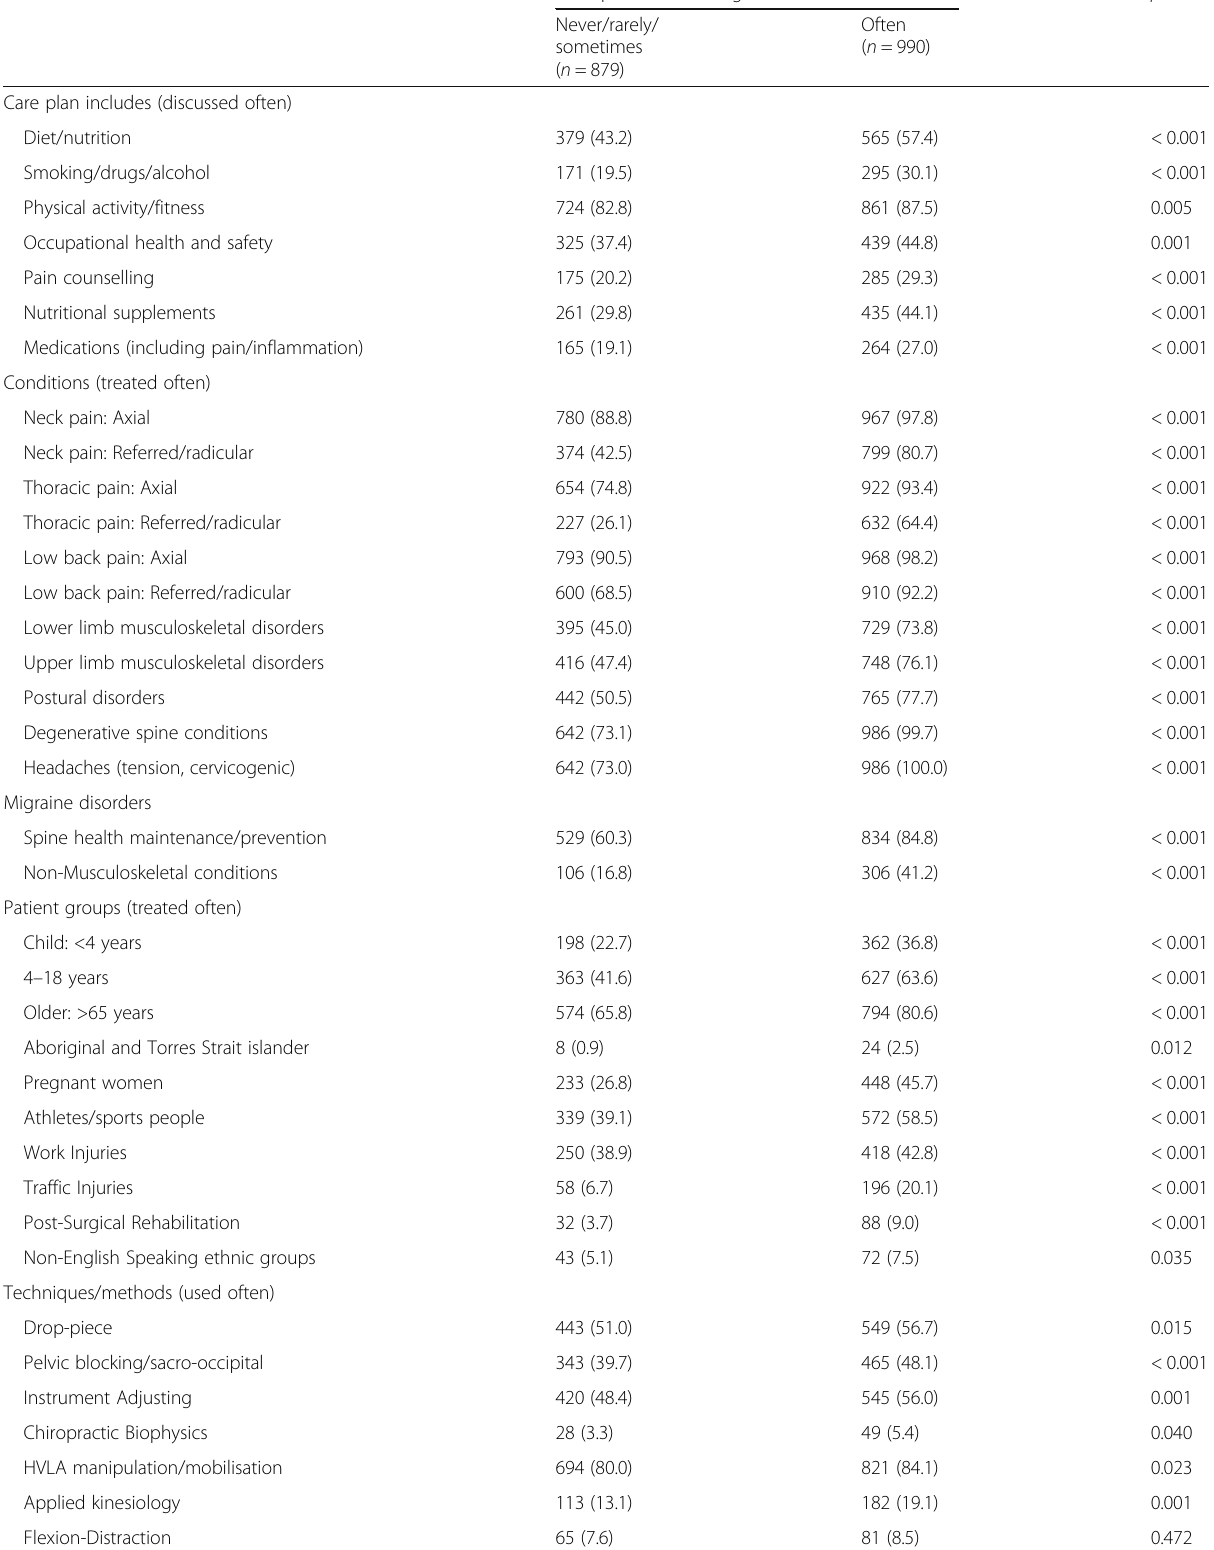
Table 3 Distribution of clinical management characteristics across frequency of practitioner treating patients with migraine